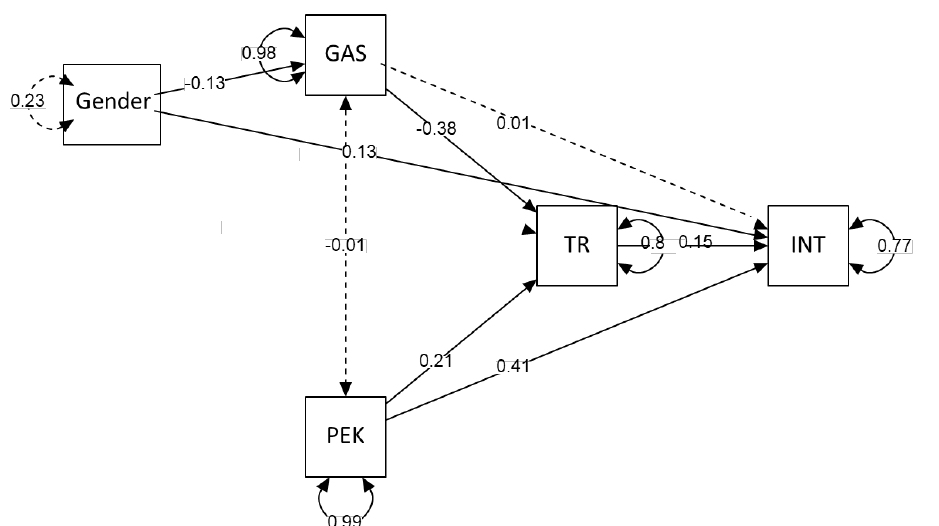
Figure 2. Results of hypothesis testing (N = 410). GAS = green advertising skepticism; PEK = perceived environmental knowledge; TR = trust in green claims; INT = intention to buy green food. Standardized parameter estimates are reported. Dotted lines indicate nonsignificant parameters. Table 5. Results of the mediation